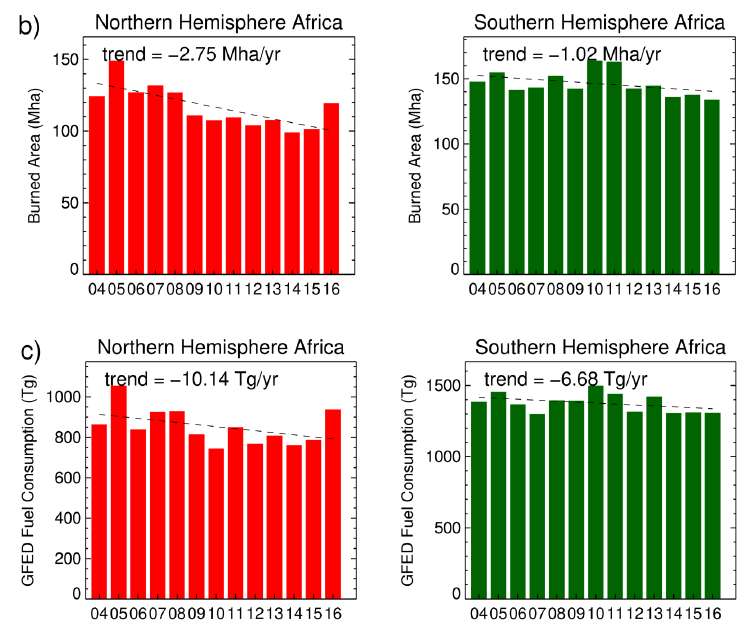
Figure 1. ( a ) Annual estimates of Spinning Enhanced Visible and Infrared Imager (SEVIRI) fire radiative energy (FRE, Tj); ( b ) Moderate Resolution Imaging Spectroradiometer (MODIS) MCD64 burned area (Mha) and ( c ) Global Fire Emissions Database (GFED, version 4) fuel consumption (Tg, DM) in the northern and southern hemisphere Africa. A least-squares linear trend line is shown. Note that in 2013, three months of SEVIRI data (March, April and May) were unavailable which will have a greater impact in the northern hemisphere where fire activity is higher during these